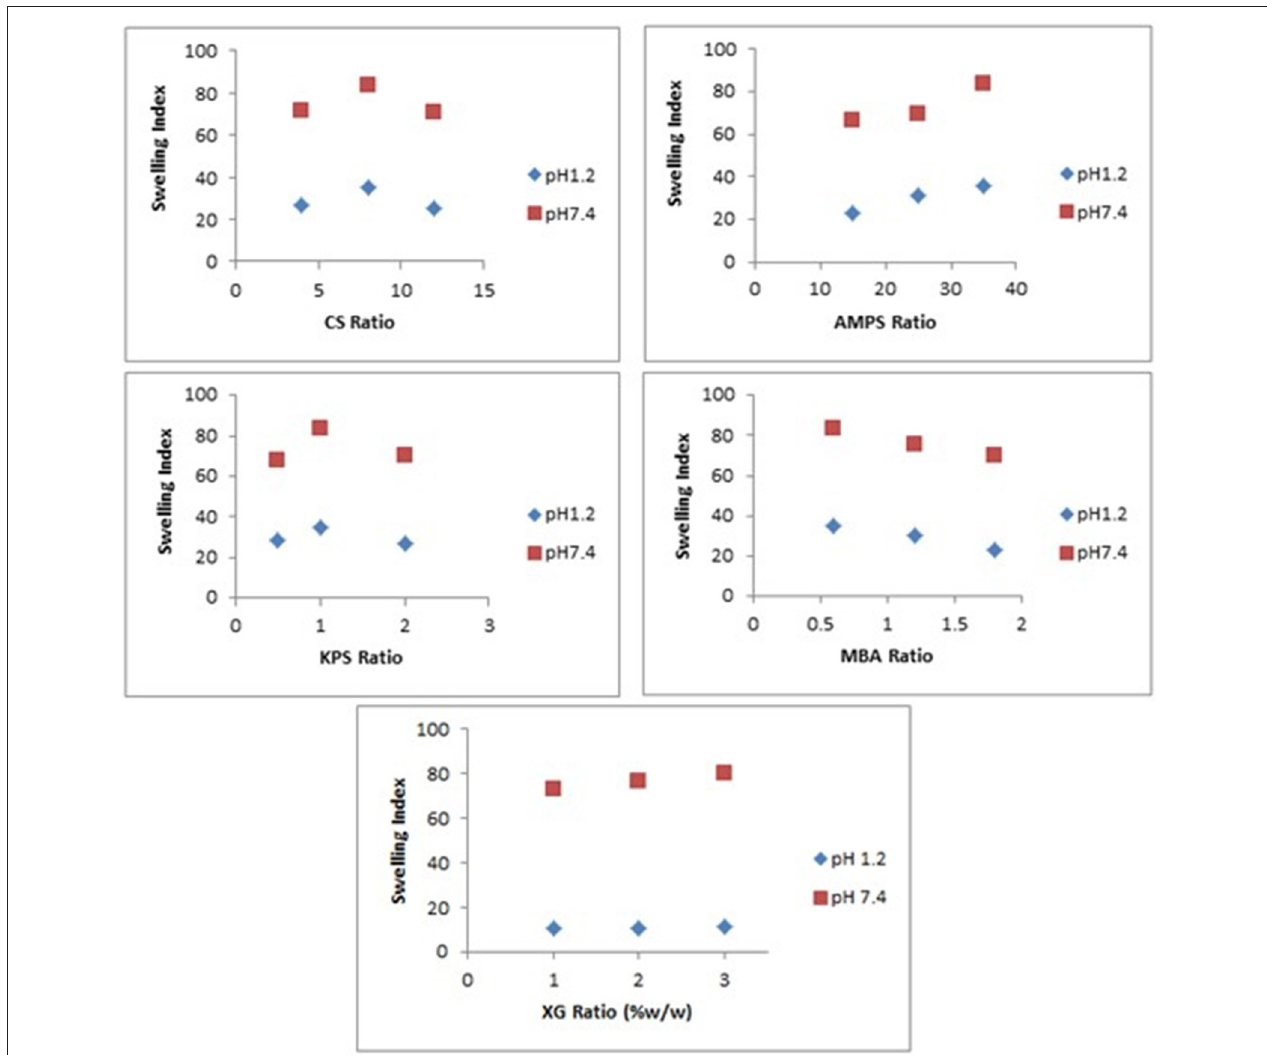
FIGURE 8 | Effect of different concentration of CS, XG, AMPS, KPS, and MBA on swelling index of hydrogels.